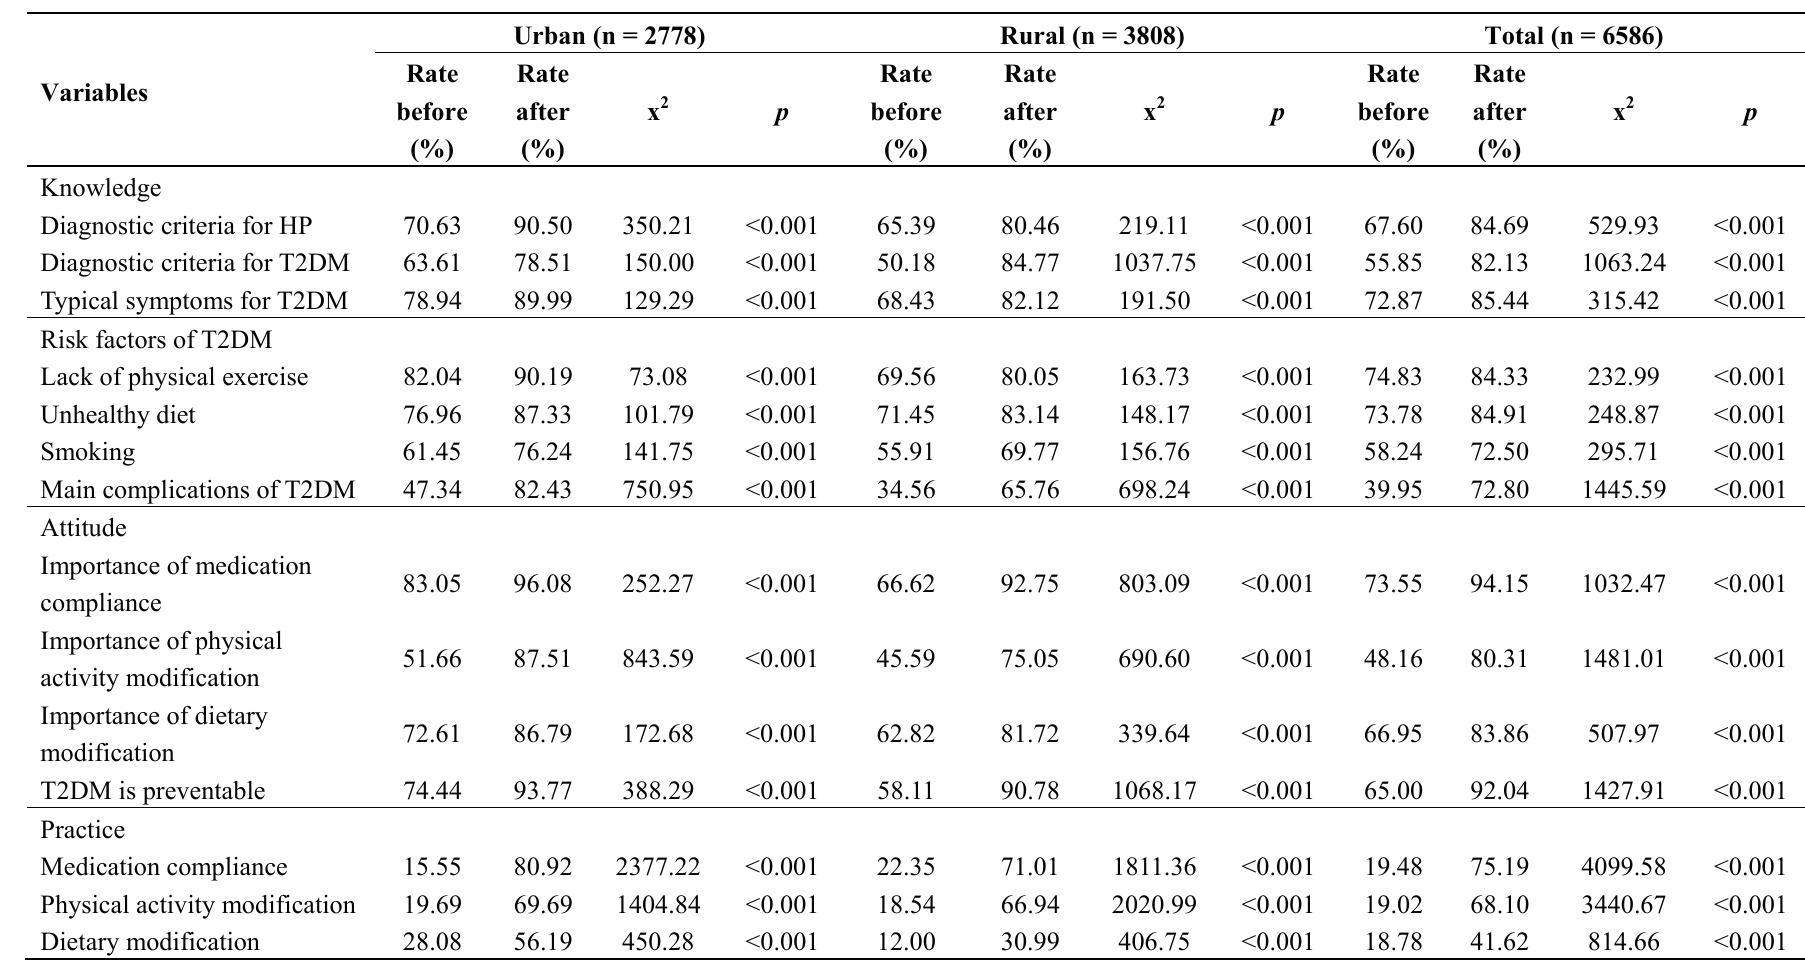
Table 3. Changes of patients’ KAP pre- and post- intervention according to urbanization